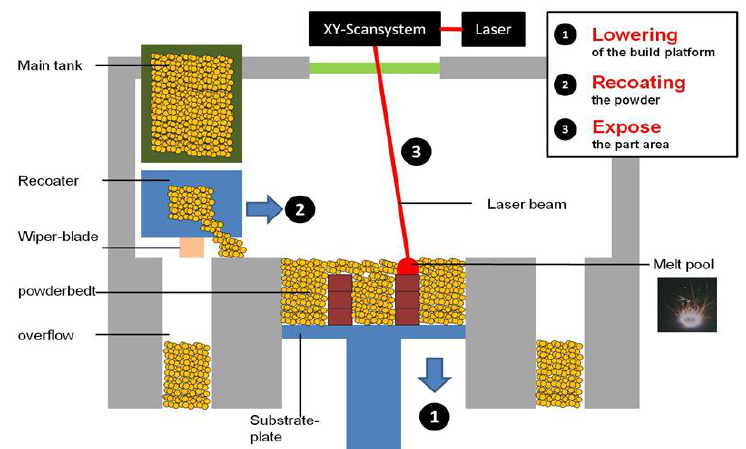
Figure 1. Schematic diagram of selective laser melting process.